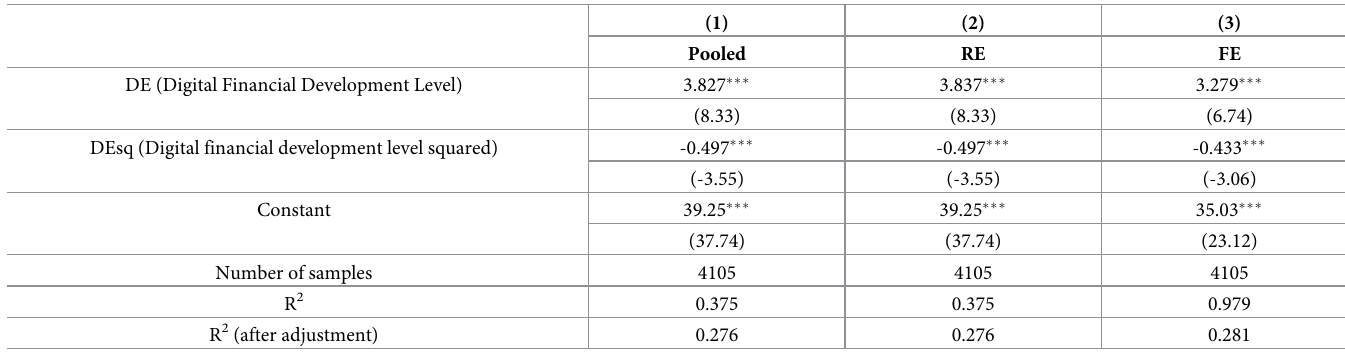
Table 3. Estimation results of the nonlinear